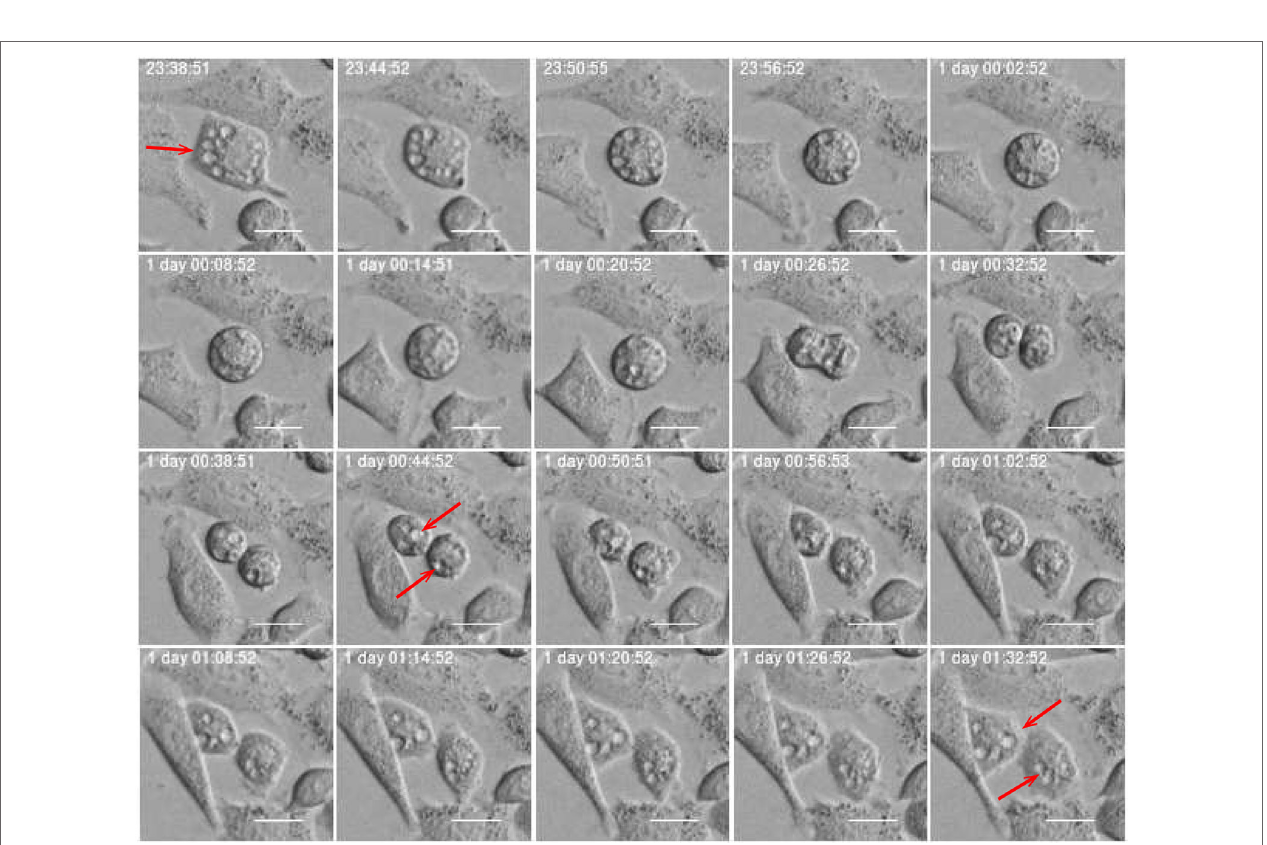
FigUre 11 | Subsequential images showing vacuole inheritance. Vacuoles (red arrow) pass from mother cell to her daughters through cell division. Scale bar: 20 µm.